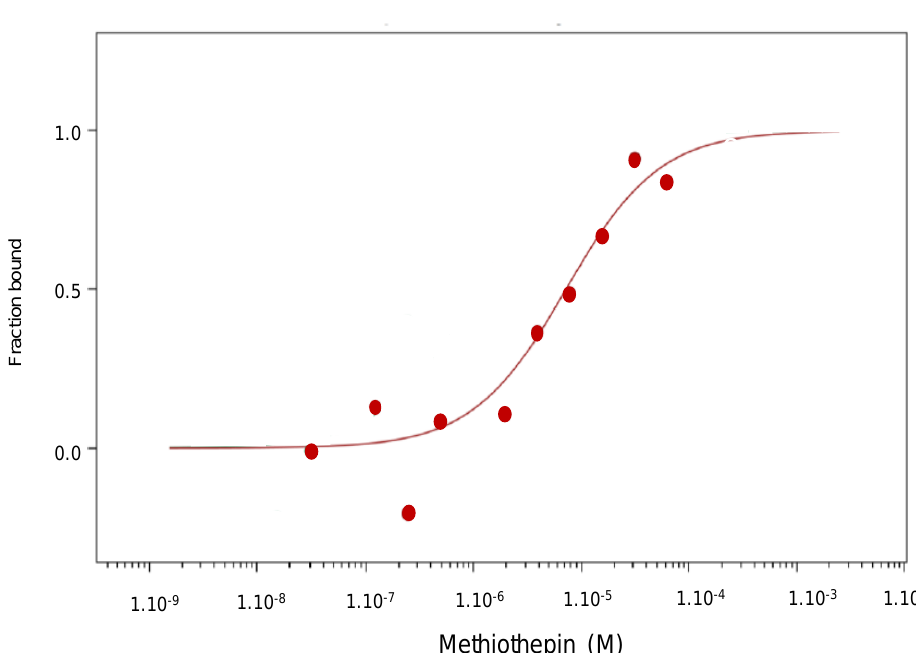
Figure 4. Direct binding of methiothepin to Ptch1. A total of 30 µ g/mL of membranes from yeast-expressing hPtch1 protein were solubilized and incubated with 20 nM of tris-NTA-NT647 fluorescent probe, and then with 250 to 15 nM of non-labeled methiothepin. After a short incubation, the samples were loaded into capillaries in a microscale thermophoresis (MST) analysis system (Monolith NT.115, LED: 30% & MST: Medium). Concentrations on the x -axis are plotted in M. A Kd of 7 µ M was determined.